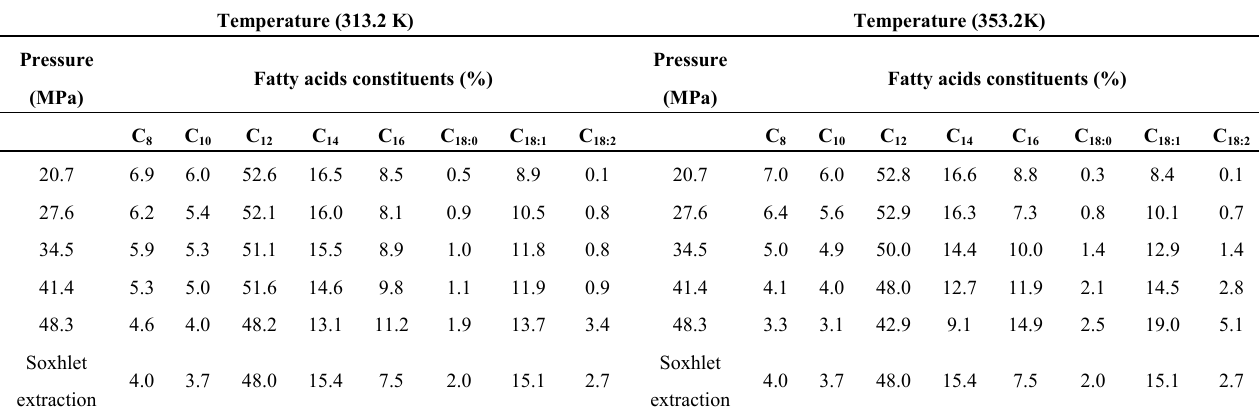
Table 3. Fatty acid constituents in palm kernel oil (PKO) extracted using Soxhlet and SC-CO at different pressure and temperature 313.2 K and 353.2 K. Reproduced with 2 substantial modification from [43].